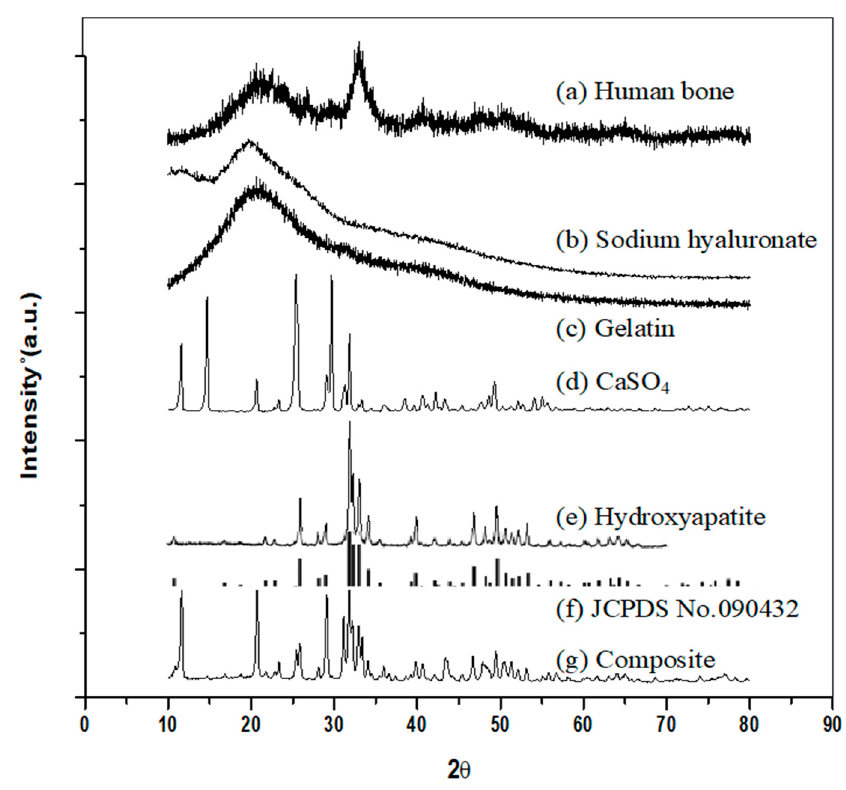
Figure 1. X-ray diffraction (XRD) patterns: ( a ) human bone, ( b ) sodium hyaluronate, ( c ) gelatin, ( d ) calcium sulfate, ( e ) hydroxyapatite, ( f ) Joint Committee on Powder Diffraction Standards (JCPDS) no. 090432, and ( g ) gelatin–hyaluronate/calcium sulfate/hydroxyapatite (Gel-HA/CS/HAP) composite.